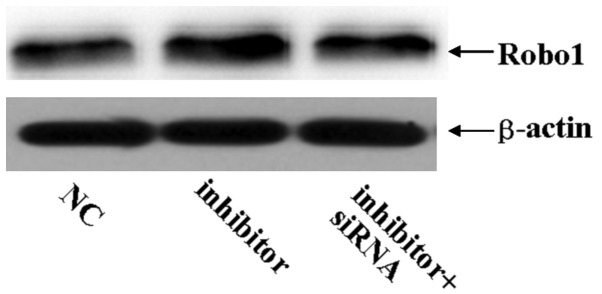
Western blot analysis revealed that the protein expression of Robo1 was significantly increased in miR-218 inhibitor-transfected U87 glioma cells. By contrast, Robo1 siRNA decreased the miR-218 inhibitor-induced increase in Robo1 protein levels. *P<0.05. Robo 1, roundabout, axon guidance receptor, homolog 1; NC, negative control; siRNA, small interfering RNA; miR-218, micro RNA 218.